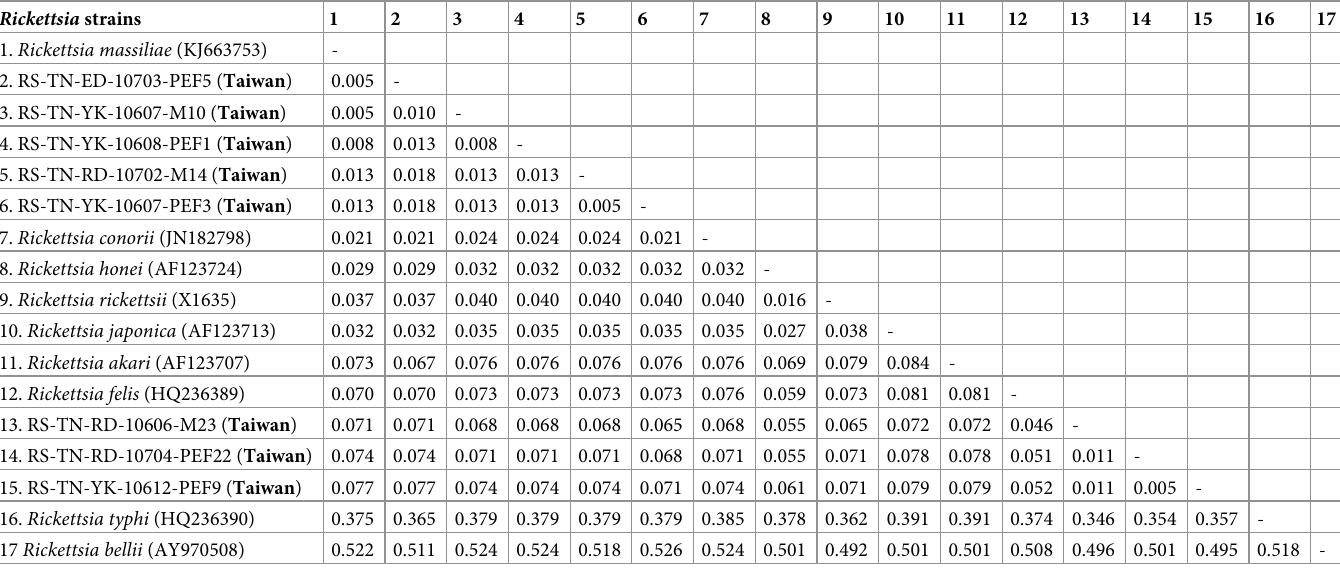
Table 3. Intra- and Inter-species analysis of genetic distance values a based on the ompB gene sequences among various Rickettsia strains. Rickettsia strains 1